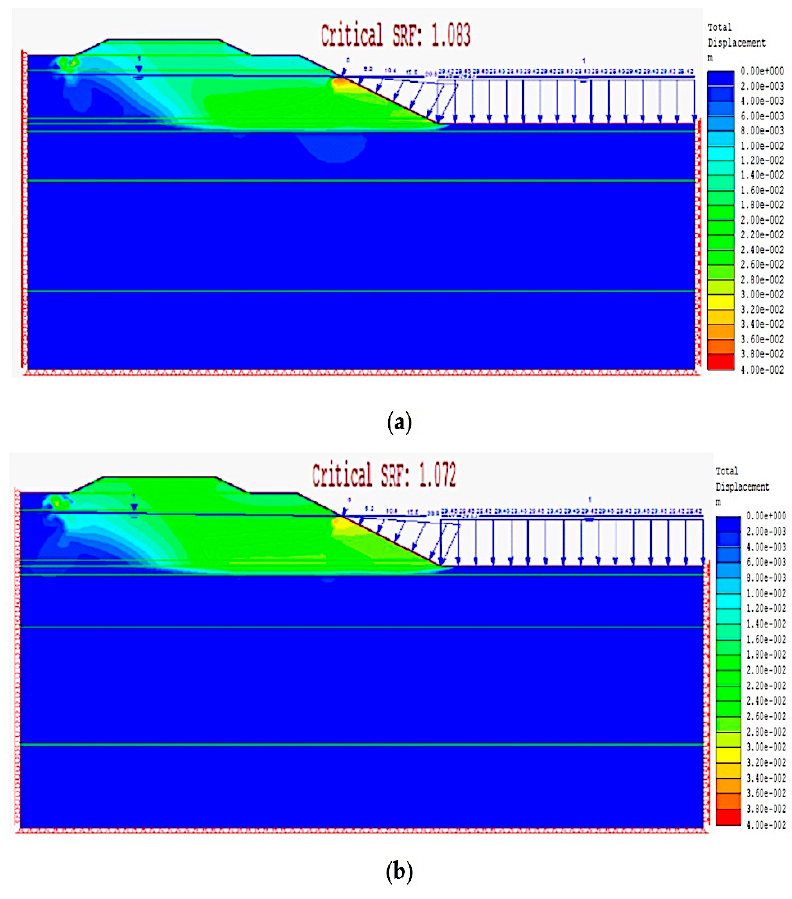
Figure 15. Colored contour shading of total displacement at SLR by ( a ) 26.70 cm and ( b ) 51.30 cm.